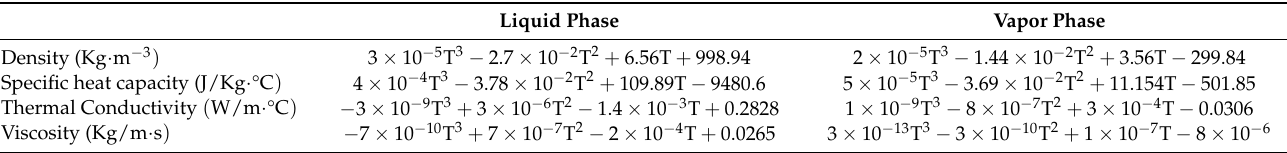
Table 3. R1233zd